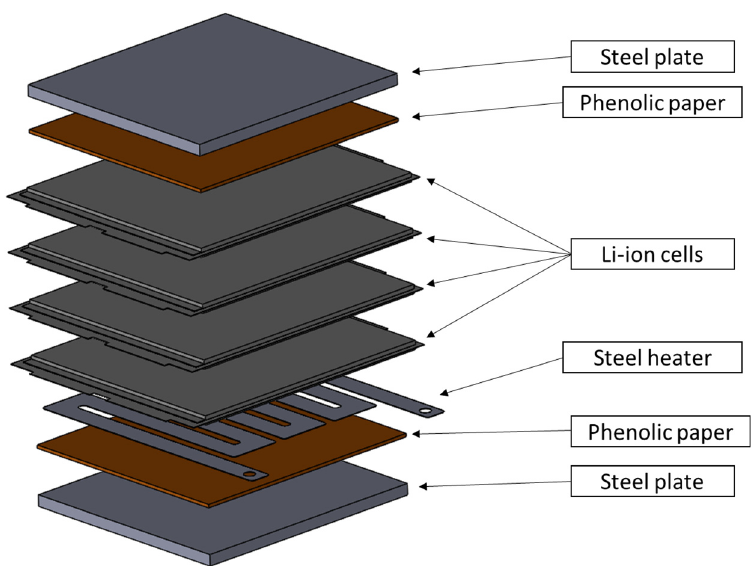
Figure 1. Parts concept description of test assembly for thermal runaway propagation test. Flat heater at bottom of stack is meant to trigger first cell without affecting mechanical compression in stack.